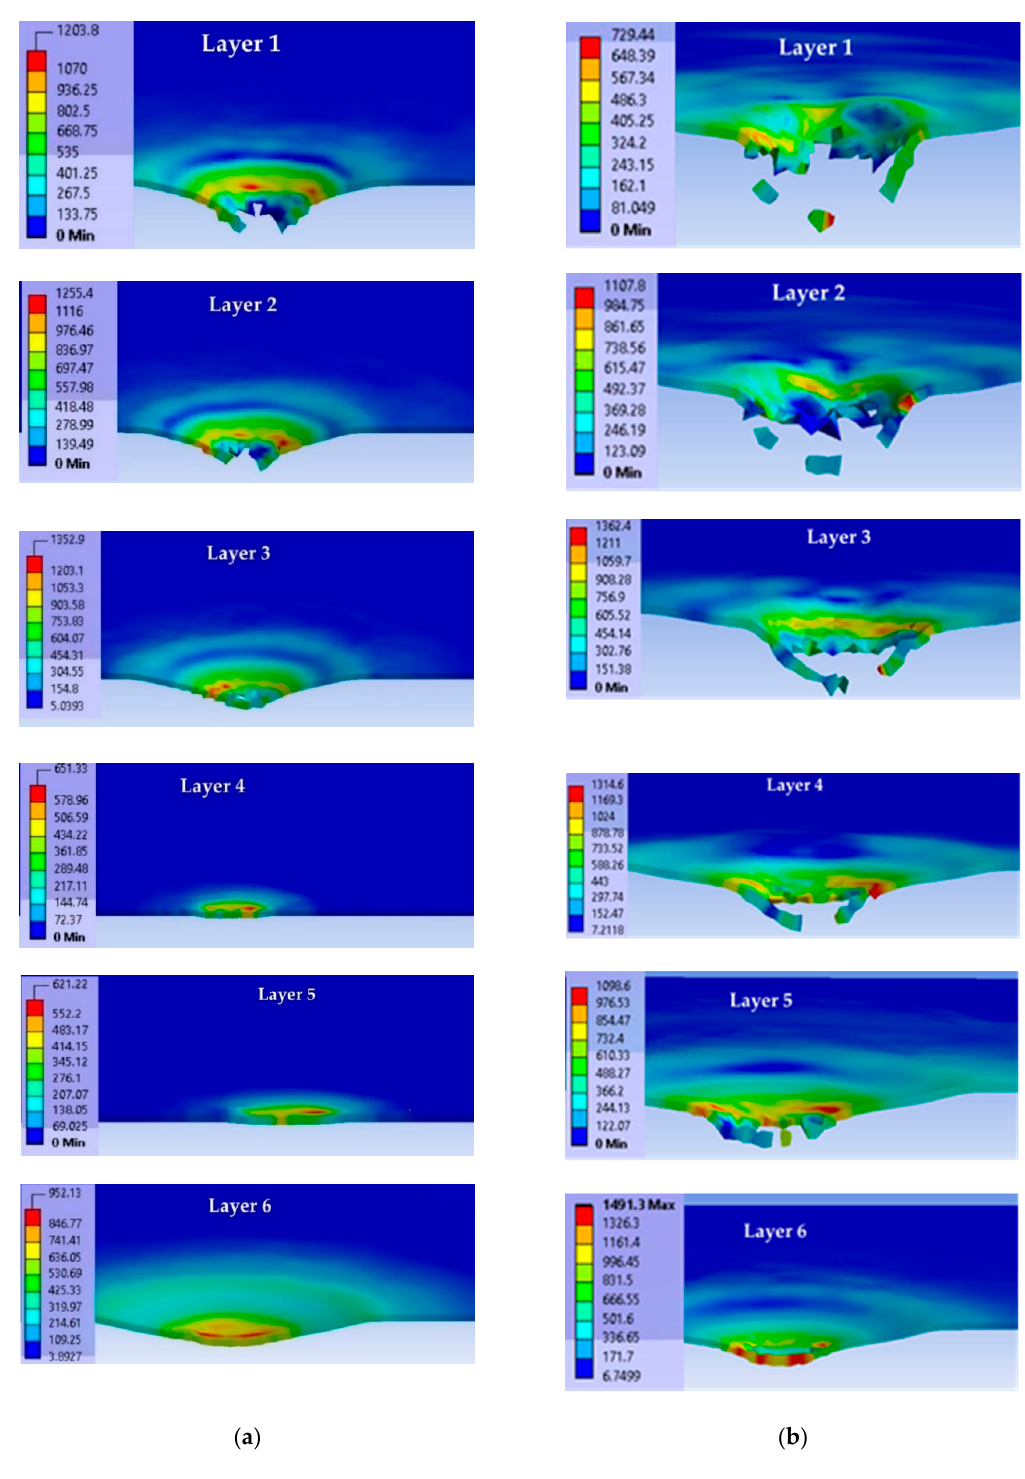
Figure 7. Cross section of each layer of the panel (the first six layers of each case) at the time moment t = 4.5 × 10 − 5 s (projectile is set as transparent). ( a ) For impact with 9 mm FMJ. ( b ) For impact with .357 Magnum.